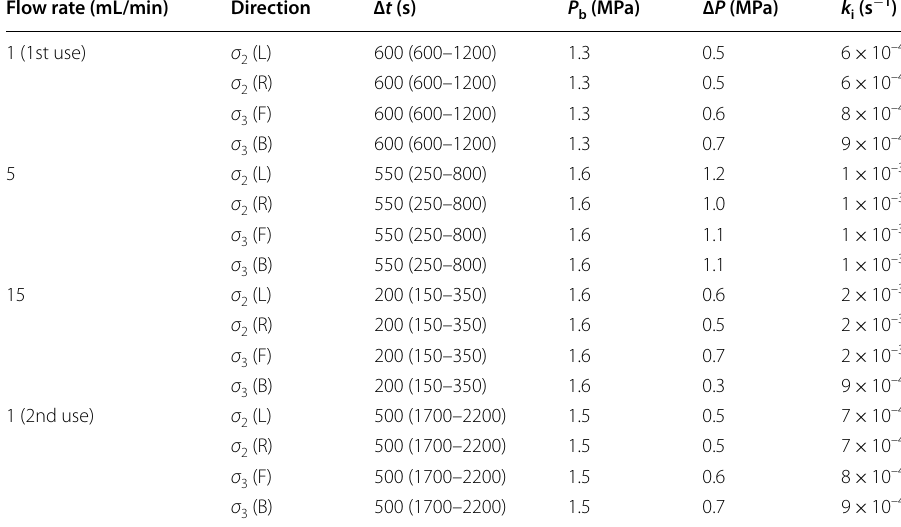
σ x (y) in the second column denotes the outlet face, y (R: right face, L: left face, F: front face, B: back face) subjected to the principal stress, σ x (x: 1, 2, 3)